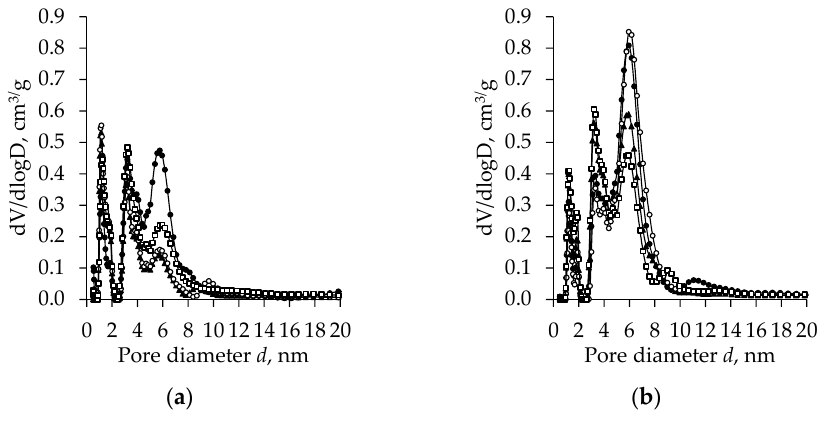
—nH, (cid:78) —CH, (cid:3) —DE) and ageing (cid:35)